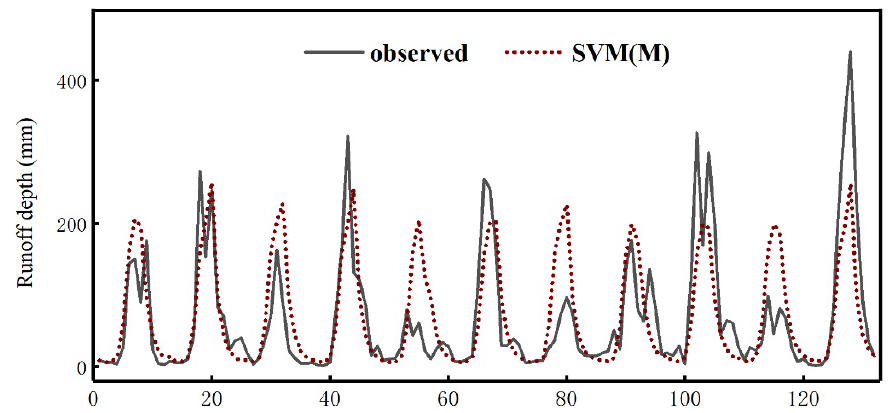
Figure 13. Prediction results of SVM (M) models.